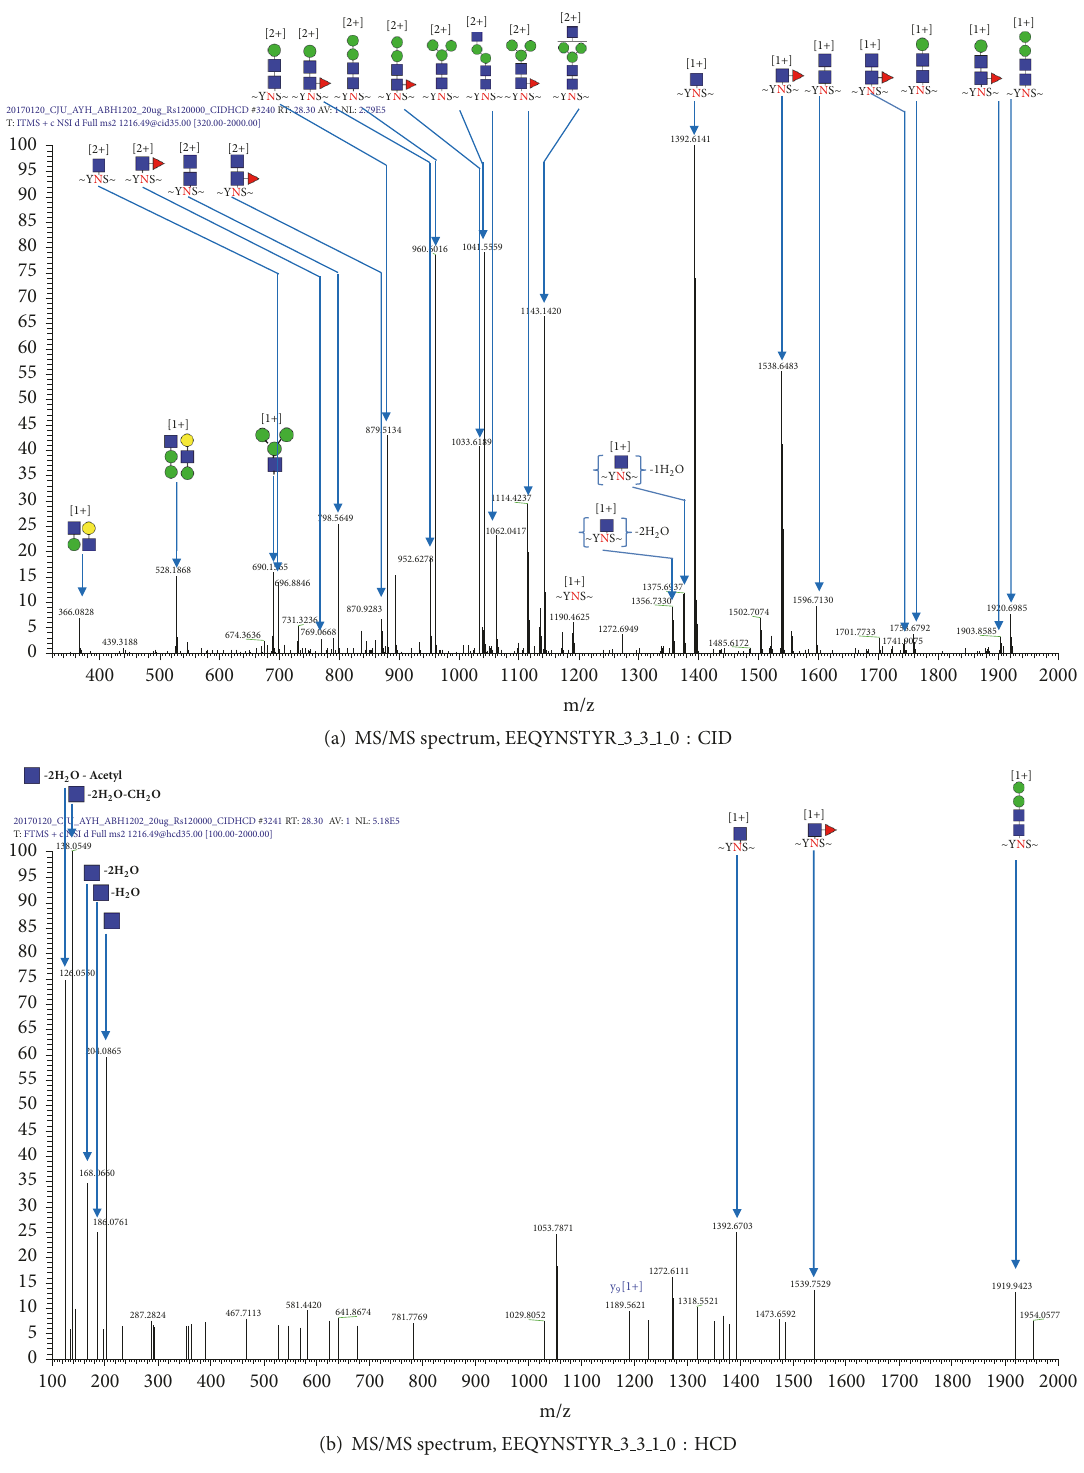
Figure 2: Tandem mass spectra of the glycopeptide EEQYNSTYR 3 3 1 0, obtained by (a) collision-induced dissociation and (b) higher- energy collision